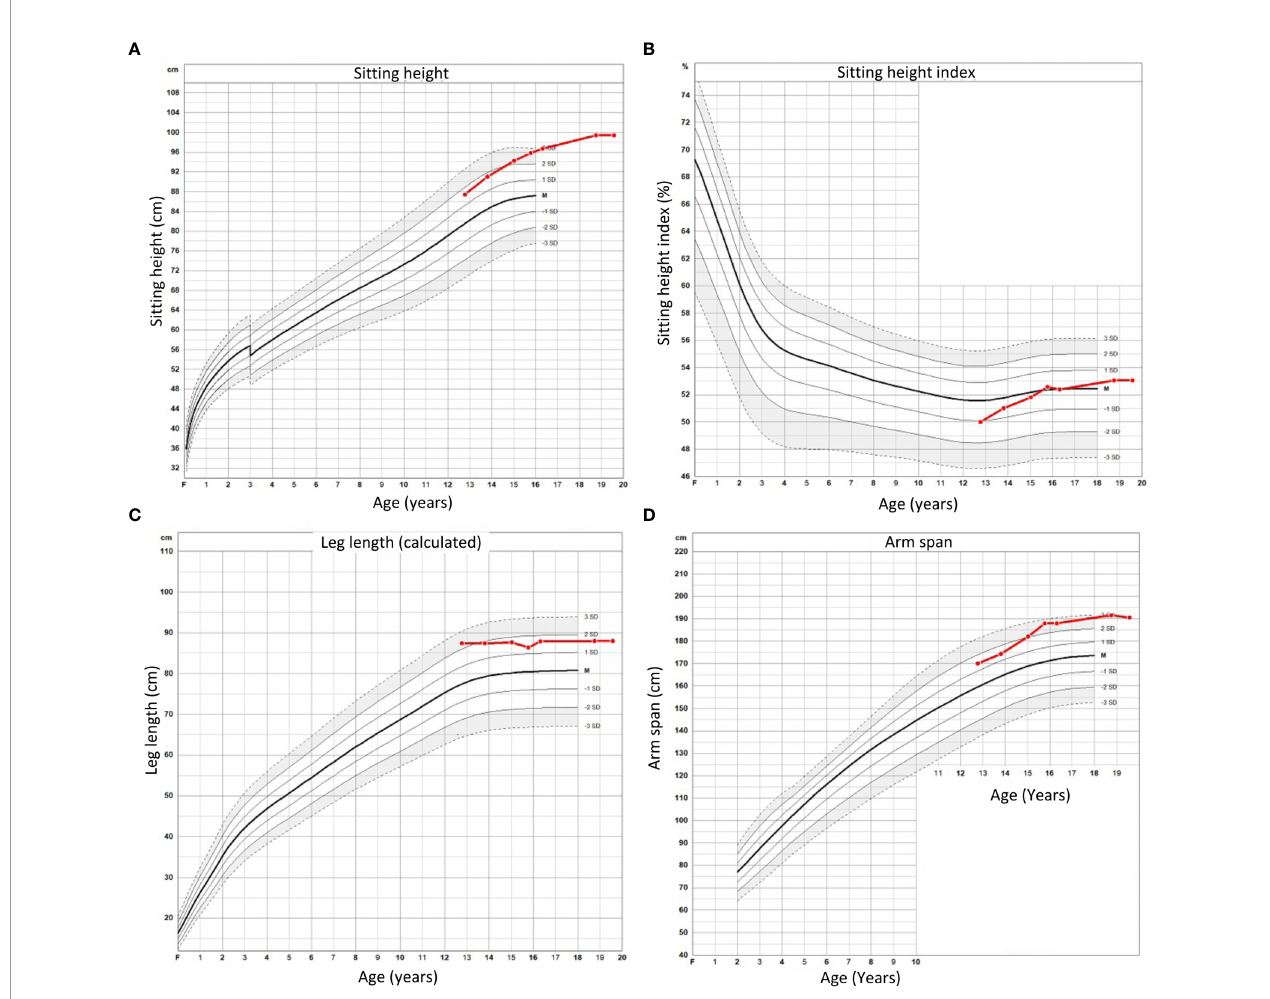
FIGURE 2 | Sitting height (A) , sitting height index (B) , calculated leg length (C) , and arm span (D) for proband from time of percutaneous epiphysiodesis surgery to fi nal